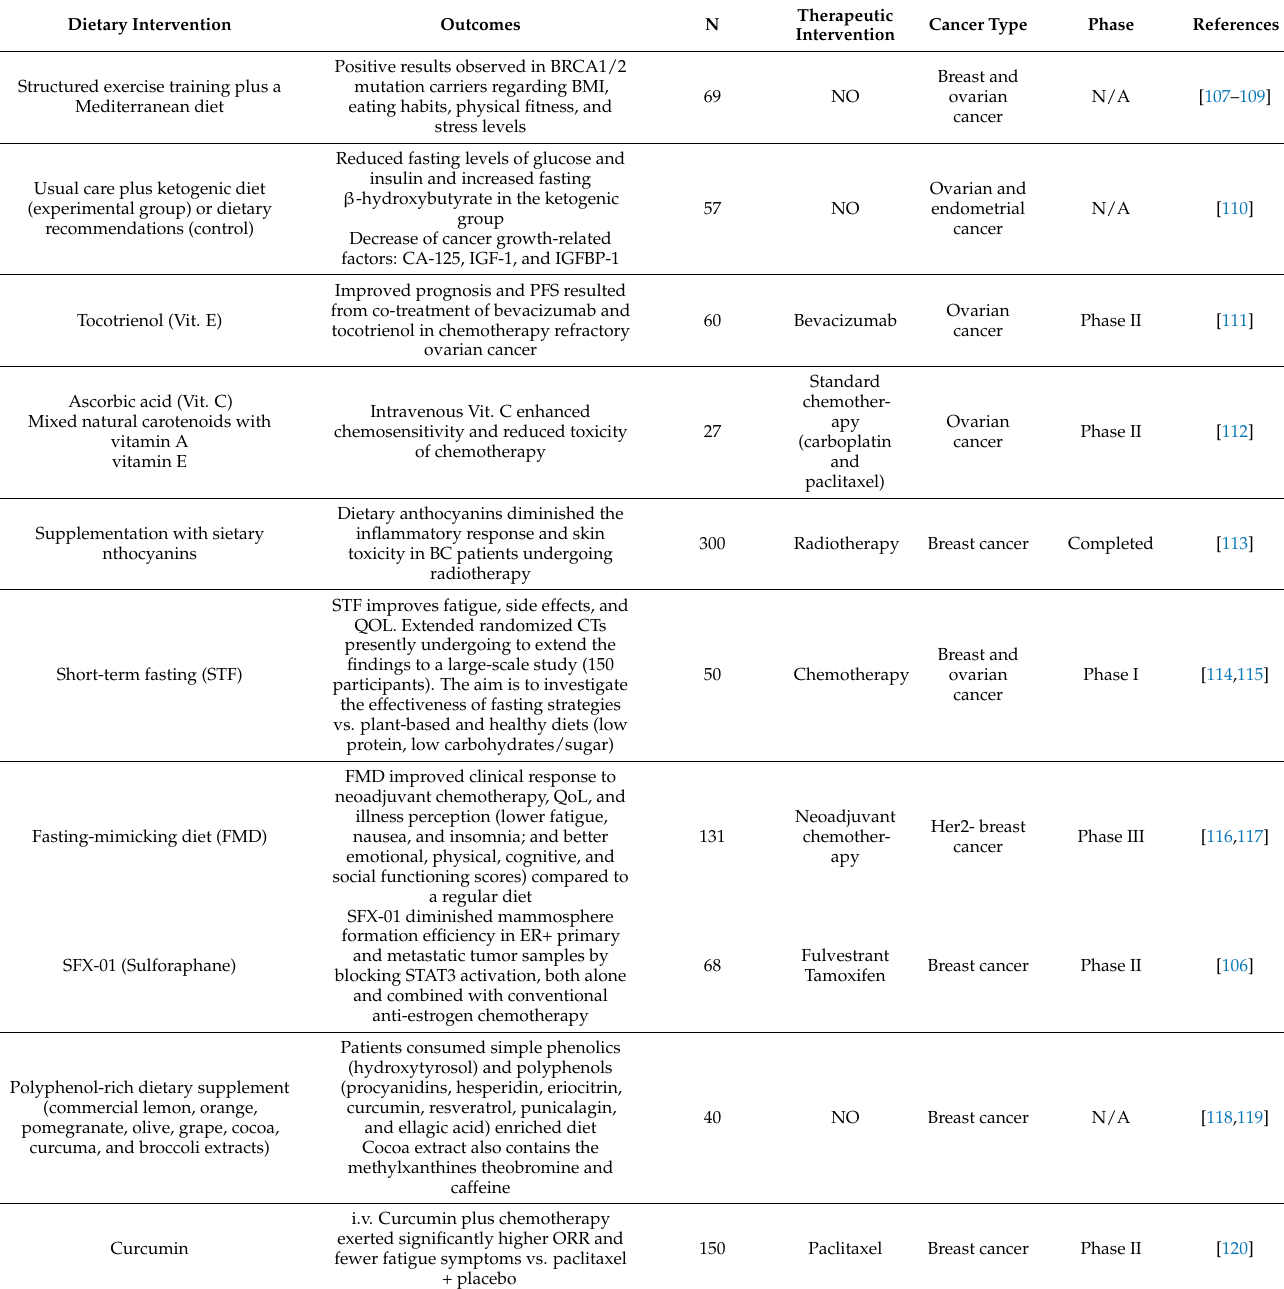
Table 2. Selected clinical trials with nutritional/dietary approaches on breast and ovarian cancer